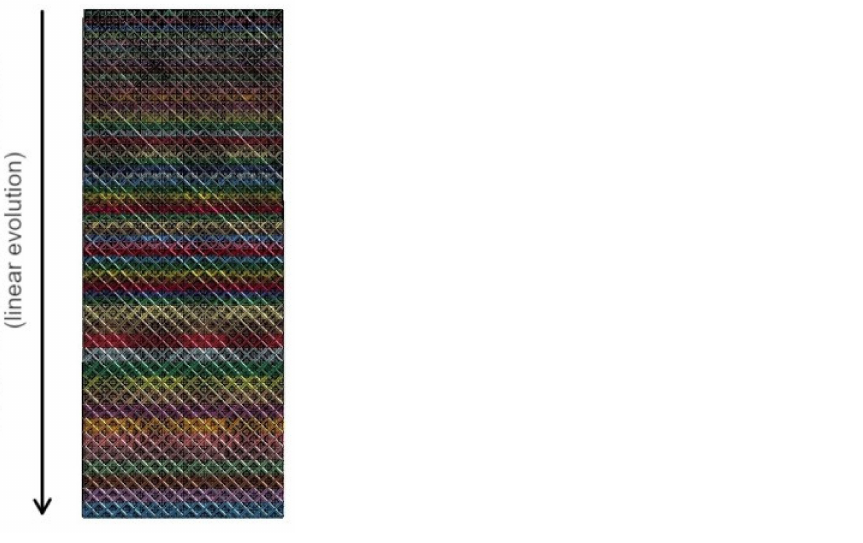
Figure 13. Geometry of the lattice crash absorber: linear variation of the beams’ diameter. The crash absorber had dimensions of 230 mm × 90 mm × 90 mm, in accordance with the envelope constraints. The linear variation of the diameter extended for 180 mm. This allowed us to obtain a total mass of the component equal to 0.795 kg, which corresponded to a mass saving of almost 25% with respect to the reference structure. Figure 14 shows the comparison of the force–displacement curves of the reference and lattice crash